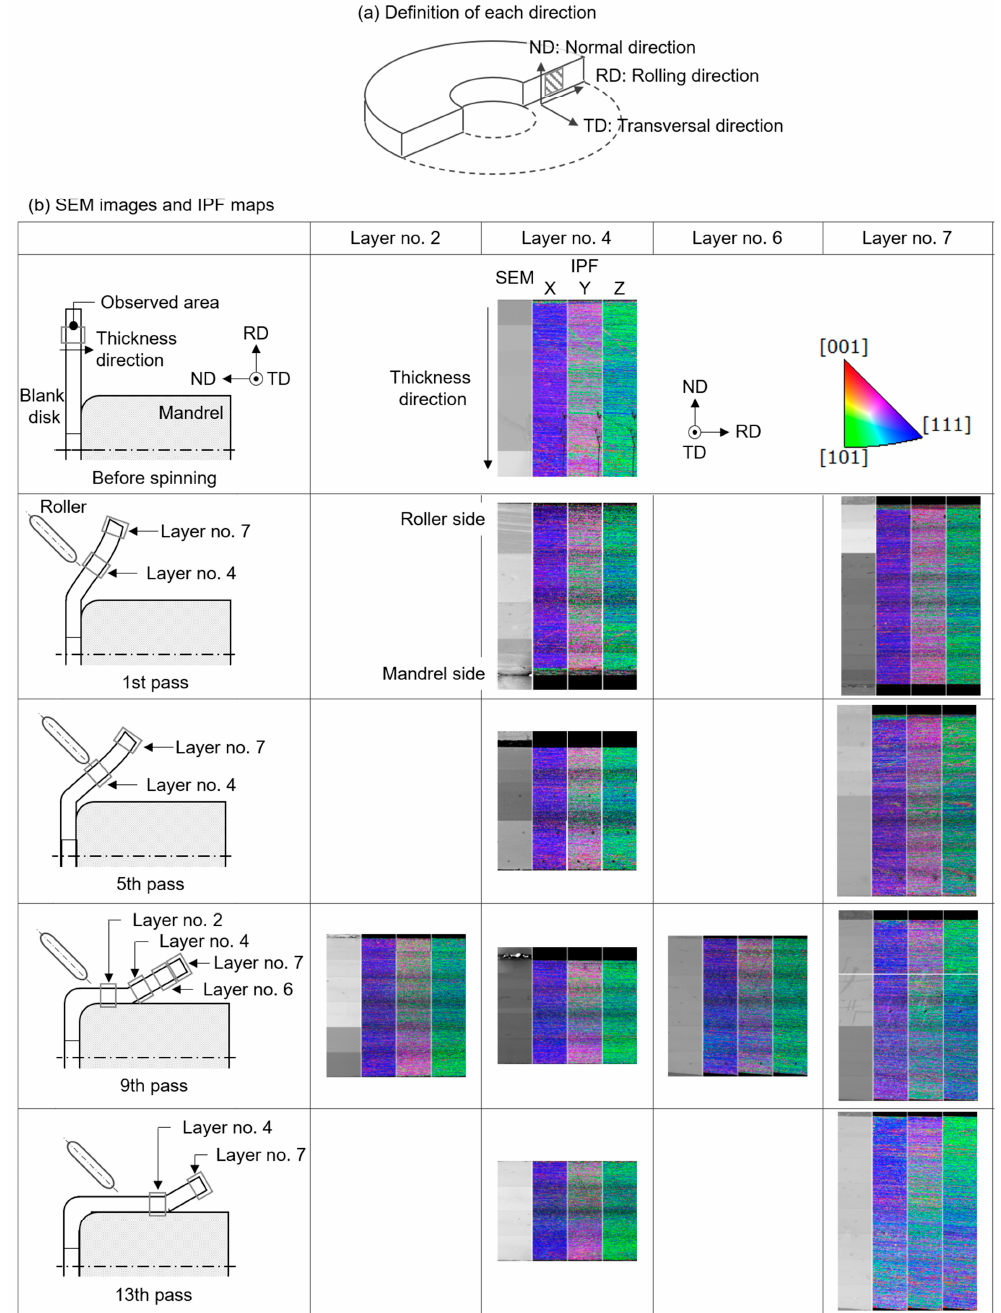
Figure 3. Evolution of the crystal orientation distribution in the thickness direction with spinning process. ( a ) Definition of the directions in the blank disk: rolling (RD), transversal (TD), and normal directions (ND). ( b ) Scanning electron microscope (SEM) images and inverse pole figure (IPF) maps for the blank disk and layers on the 1st, 5th, 9th, and 13th passes.